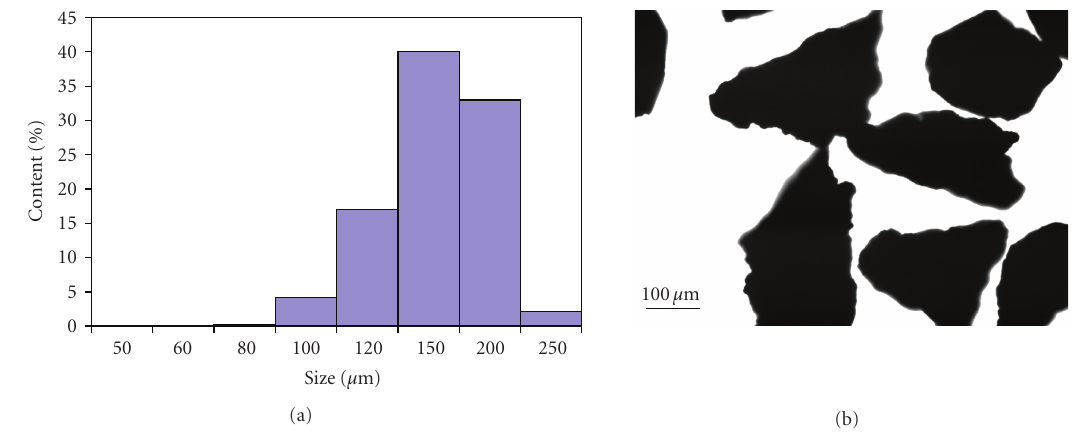
Figure 2: (a) Size distribution of the powder WC-17Co. (b) Microimage of the powder WC-17Co; light microscopy in transmitted light.